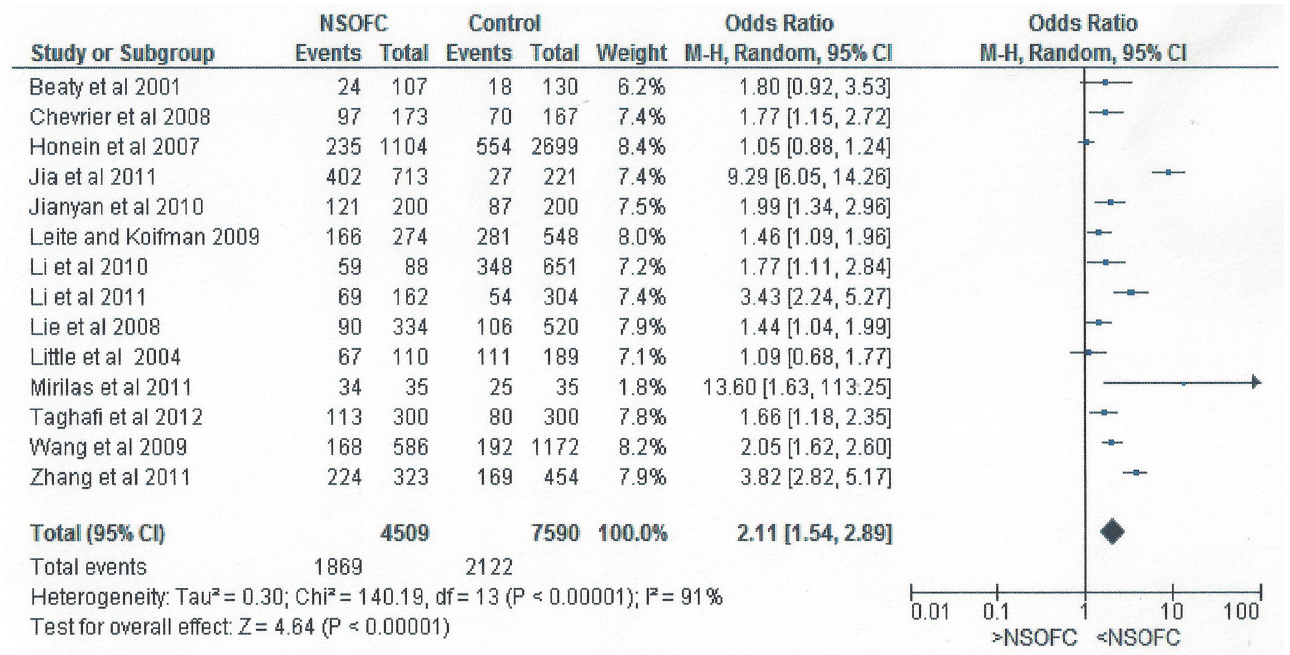
Fig 2. Forest plot for meta-analysis of the association between maternal passive smoking and the risk of having an infant with NSOFC.